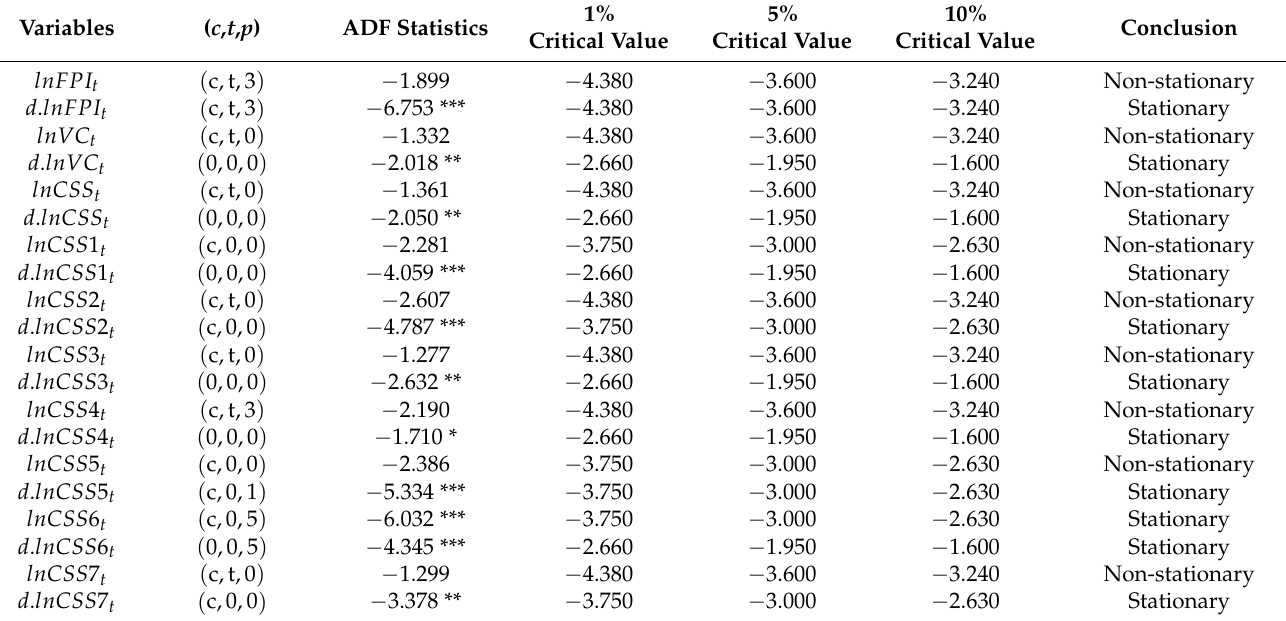
Table A2. Results of the unit root test of the variables.